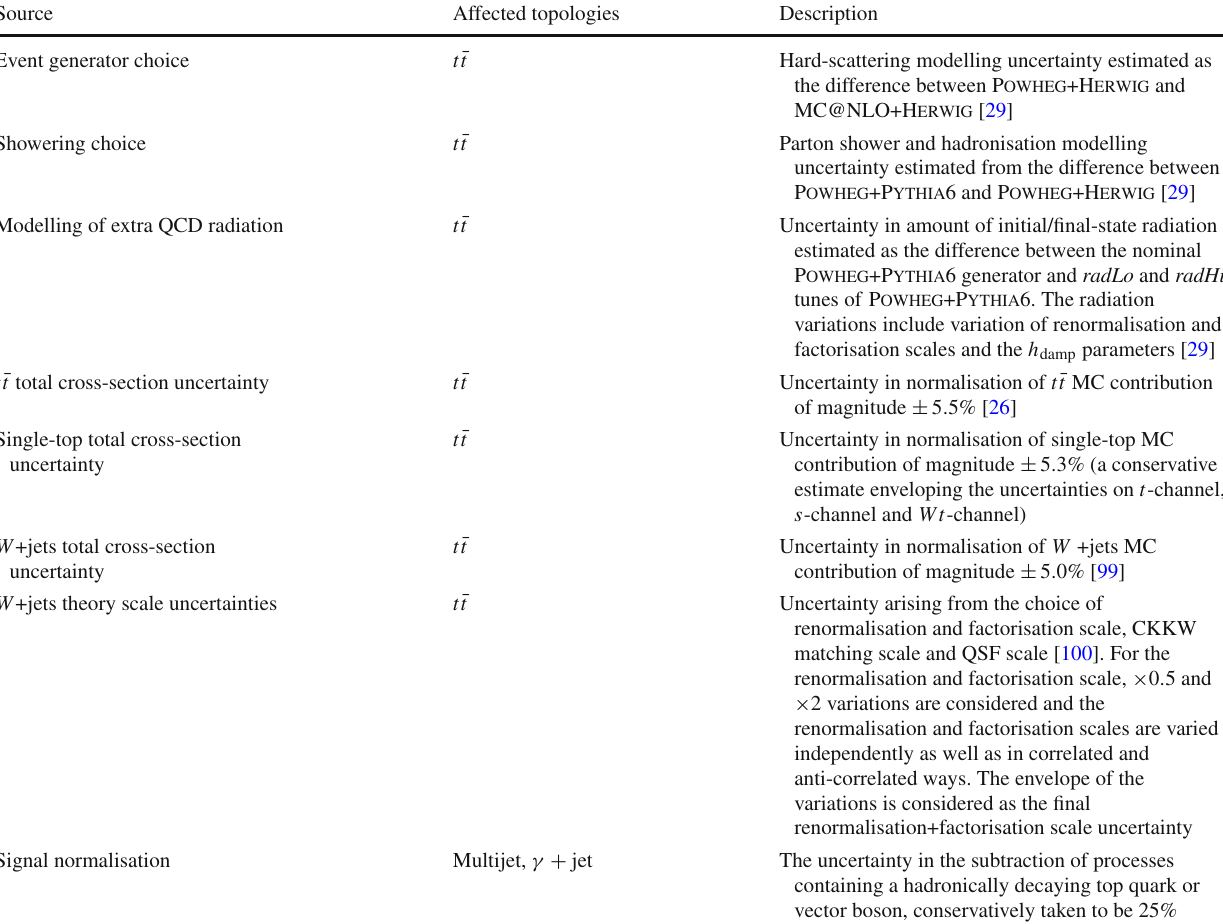
Table 3 Summary of theoretical systematic uncertainties considered in the performance measurements in